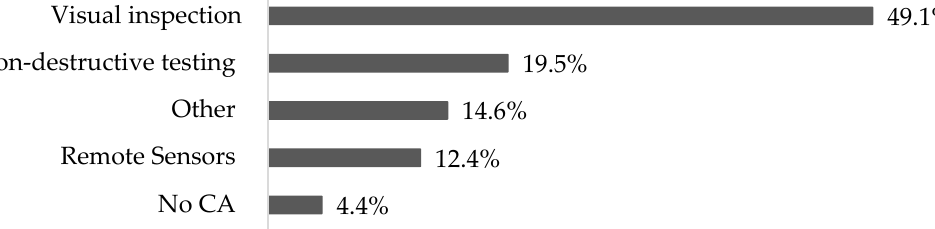
Figure 8. Distribution of the methods utilized in condition assessment.